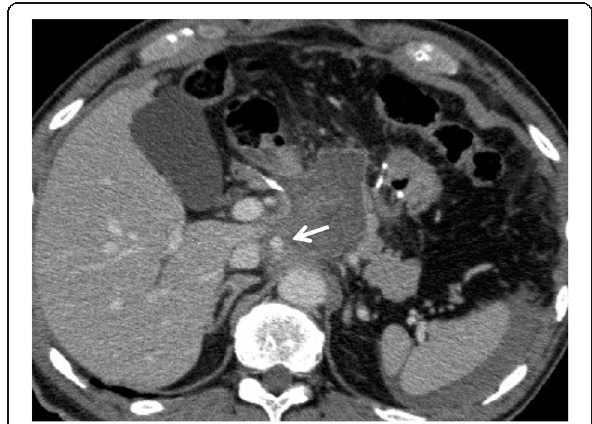
Fig. 1 CT revealed a 60 × 70-mm hematoma and a 10-mm pseudoaneurysm (arrow) in the